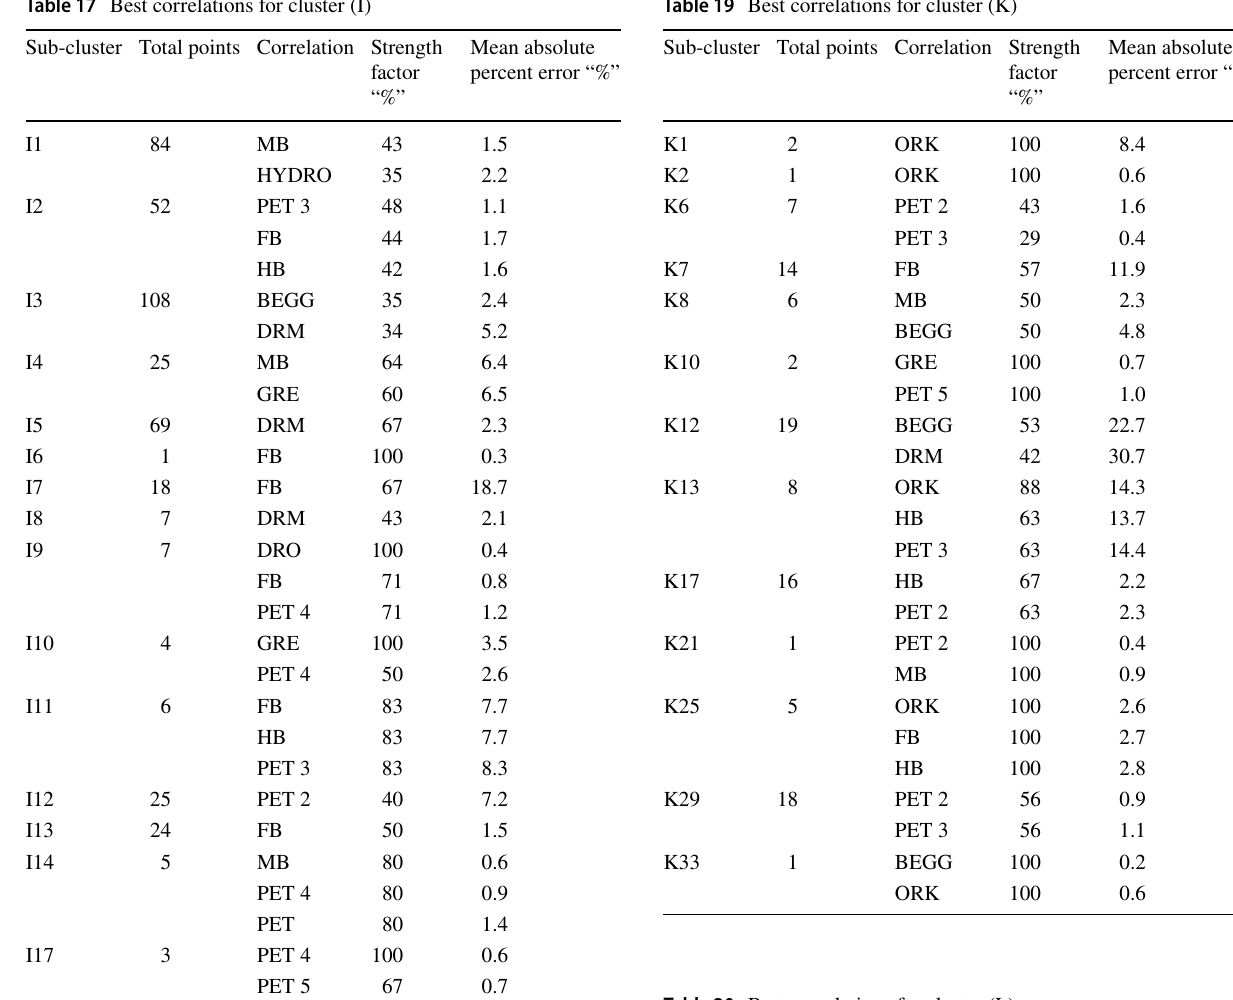
Table 19 Best correlations for cluster (K)